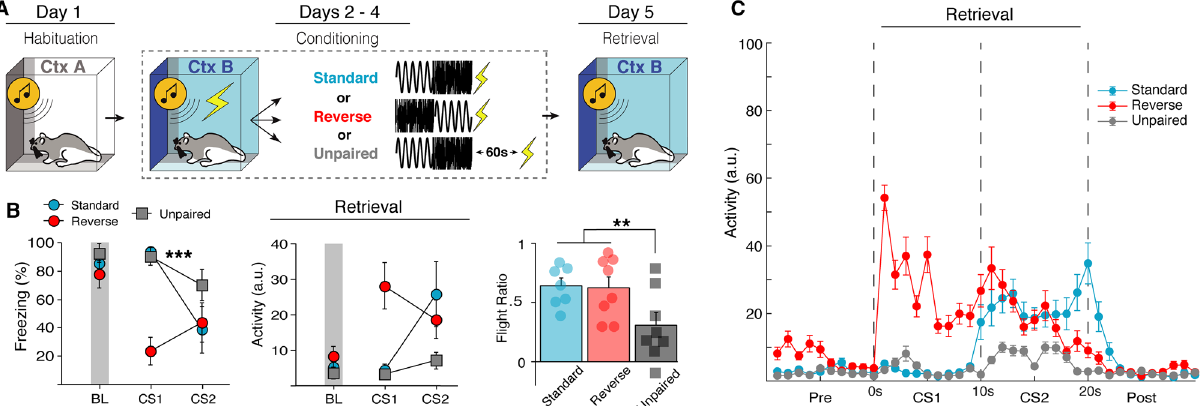
Figure 4. Flight-like responses in rats are specific to white noise and not due to sensitization. ( A ) Behavioral design. ( B ) Average freezing and activity data showing that flight-like behavior is specific to the white noise stimulus regardless of the temporal of order of the SCS. In a Reversed order SCS, rats show a decrease in freezing and corresponding increase in activity to the first stimuli (noise) rather than the second (tone). The data additionally show that unpairing the SCS and US with a 60-s gap (Unpaired) prevents flight-like behavior compared to Standard SCS-US controls. This all further shown by averaged activity time across time ( C ). All data are represented as mean ± SEM pooled across sex [Standard ( n = 7); Reverse ( n = 8); Unpaired ( n = 8)]; *, **, and *** denote p < 0.05, p < 0.01, and p < 0.001,